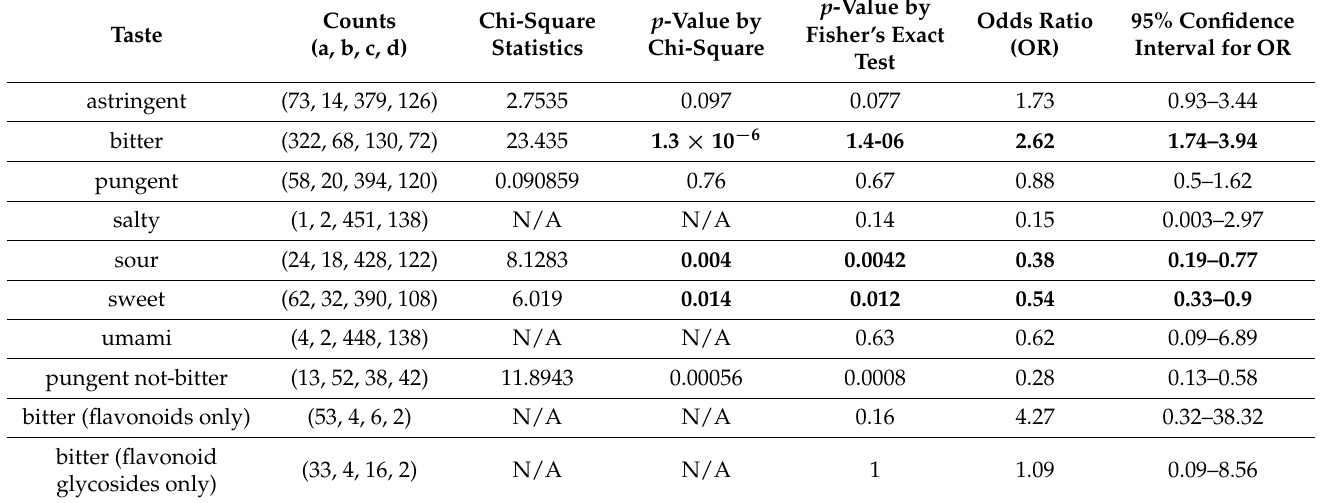
Table 1. The correlation between anti-inflammatory activity and taste. Legend: AIA—anti- inflammatory activity; N/A—not applicable; Note. The second column contains the number of phytocompound in each of the 4 cells of the 2 × 2 tables used for performing Chi-square test and/or Fisher’s exact test: a = taste + AIA+, b = taste + AIA − , c = taste − AIA+, d = taste − AIA − . Statistically significant results are bold